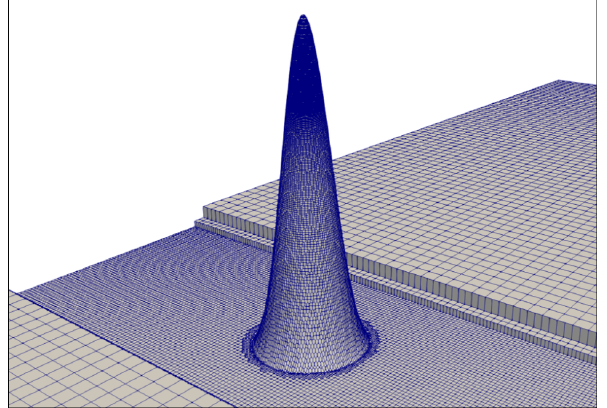
Figure 17. Schematic of the local refinement of the grid.